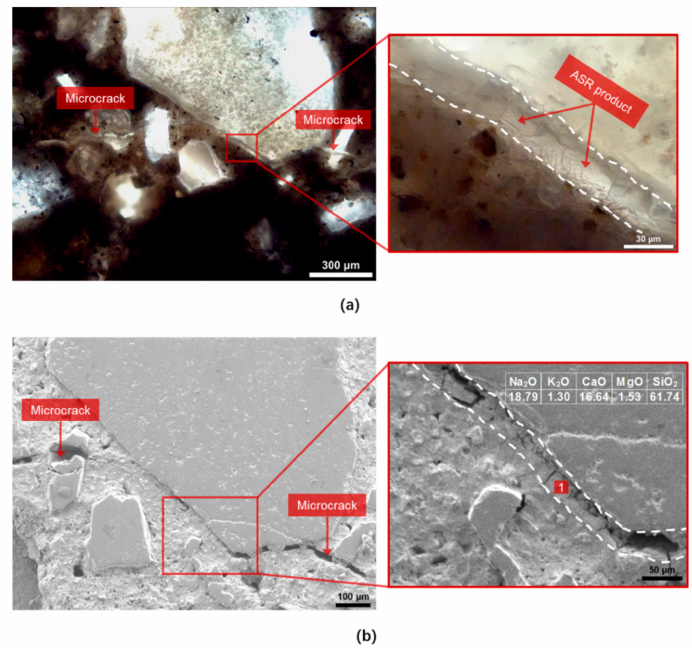
Figure 3. ( a ) Typical polarized light microscopic image of the microcracks and alkali-silica reaction (ASR) products formed in the OPC concrete prism specimens after 1-year CPT. ( b ) Secondary electron (SE) image on the same location with chemical composition (wt. %) of ASR product (site